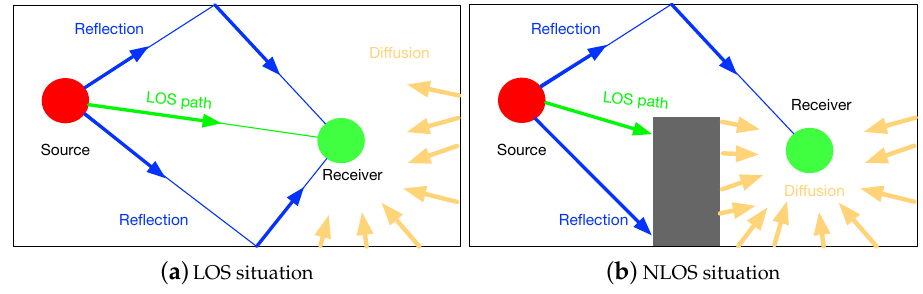
Figure 1. Line-of-sight (LOS) and non-line-of-sight (NLOS) situation